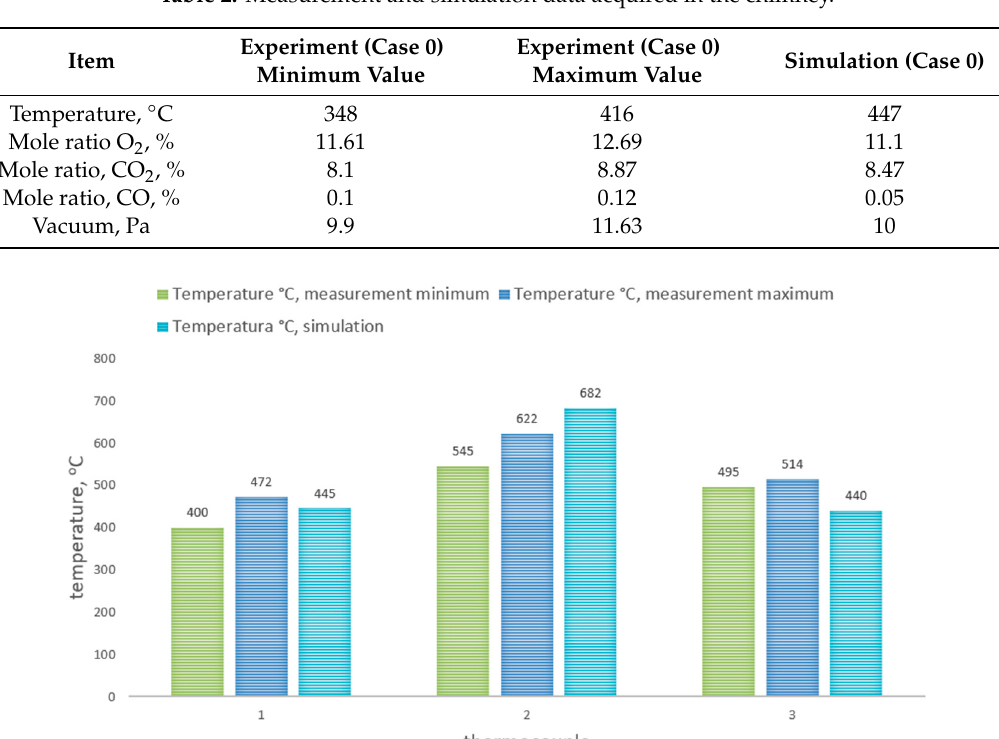
Figure 8. Change in temperature as a function of time for the three thermocouples (1, 2, and 3) shown in Figure 4, which register the exhaust gas temperature flowing around the deflector (Case 0). Table 2. Measurement and simulation data acquired in the chimney. Table 2. Measurement and simulation data acquired in the chimney.